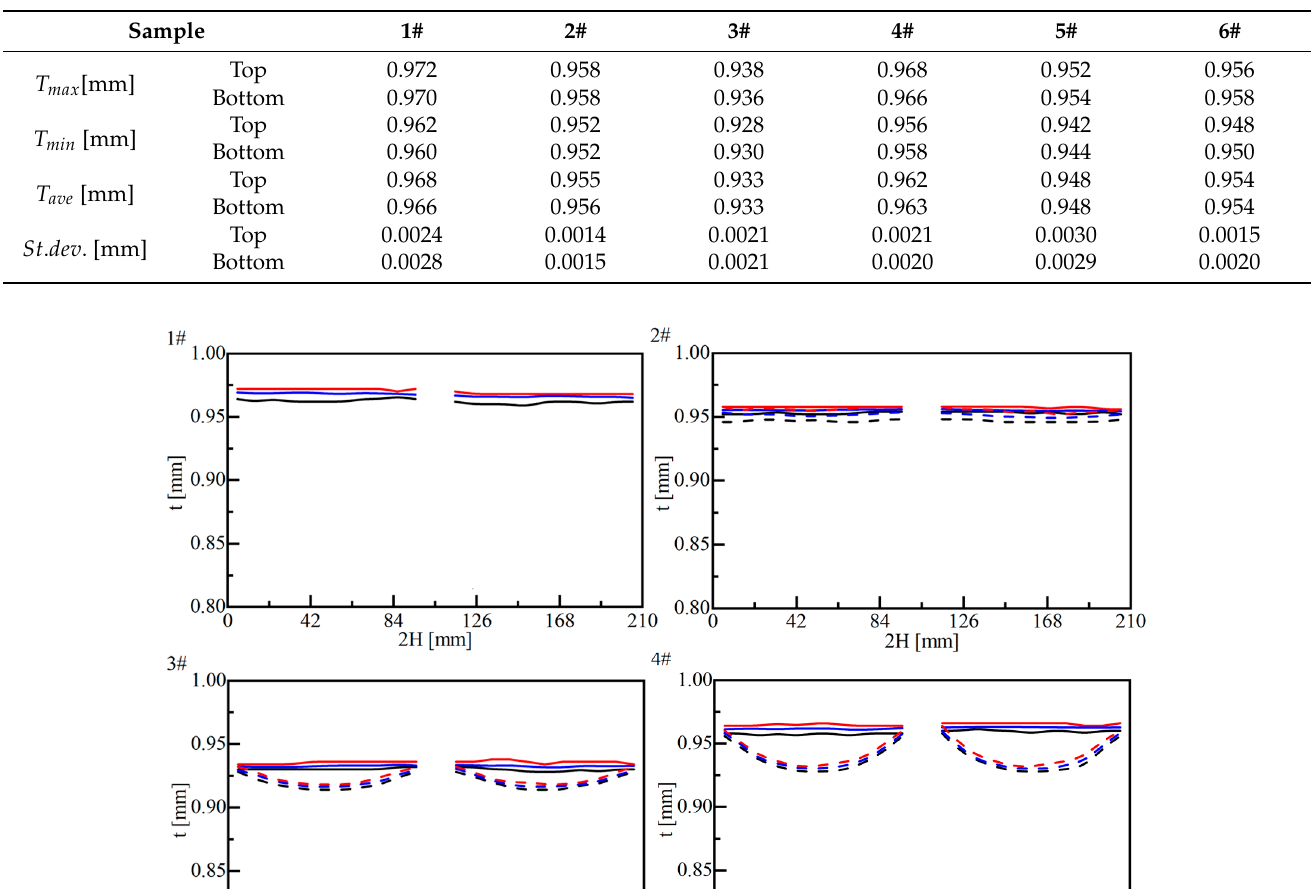
Table 5. Maximum, minimum, and average thicknesses of bi-segment cylindrical performs and their corresponding standard deviations.